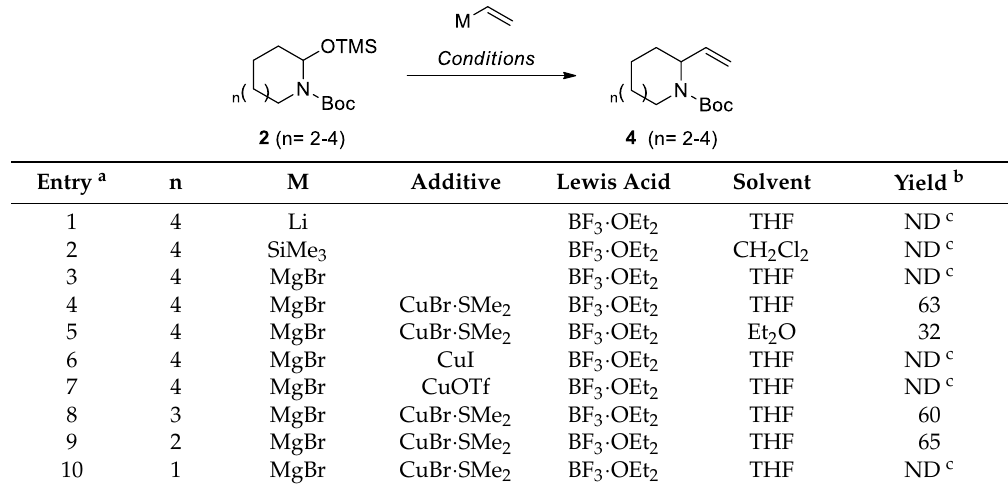
Table 1. Vinylation of N , O -acetal TMS